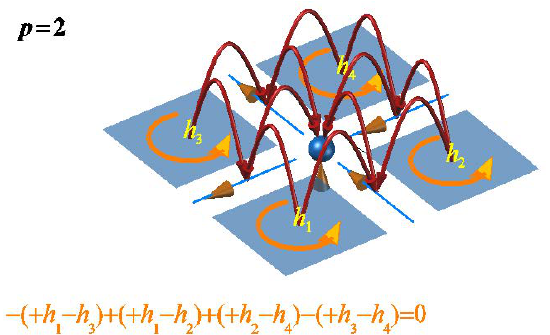
Figure 57: How to find the weight of a ( p − 2) -cell starting from the weights of the cofaces of its cofaces: a two-dimensional example.